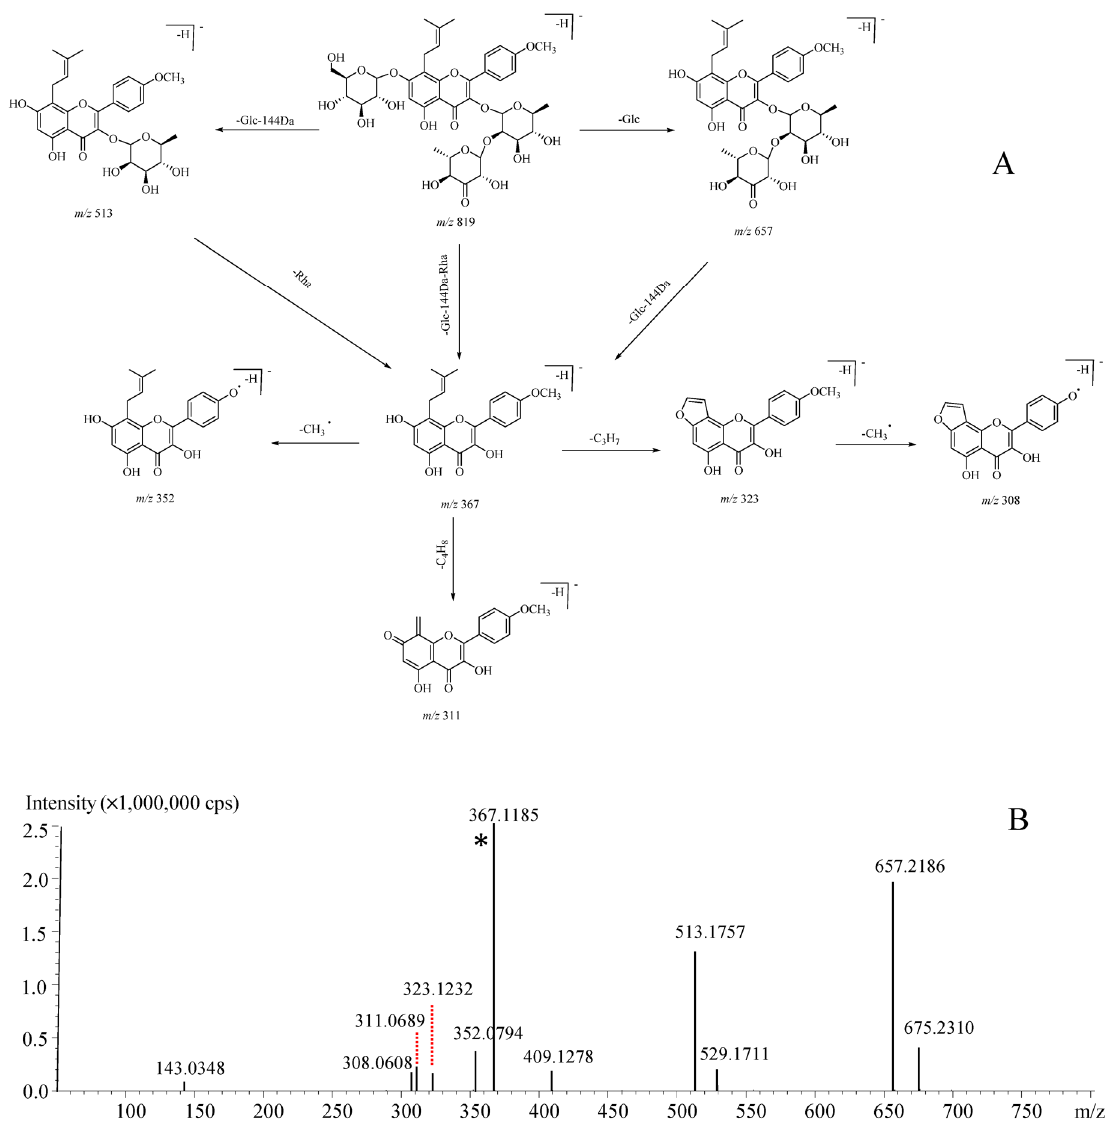
Figure 4. Proposed mass cracking pathways ( A ) and MS 2 spectrum ( B ) for oxidized epimedin C that was featured by the 144 Da neutral loss. *: Y 0 −